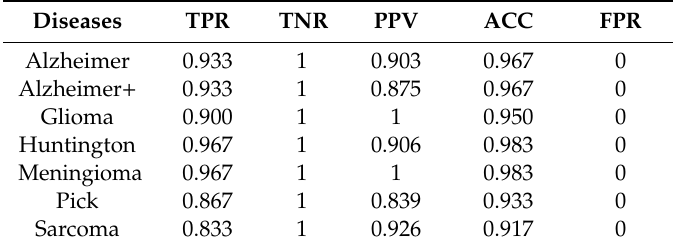
Table 2. The results of the classification for eight-class states using PCA + LDA